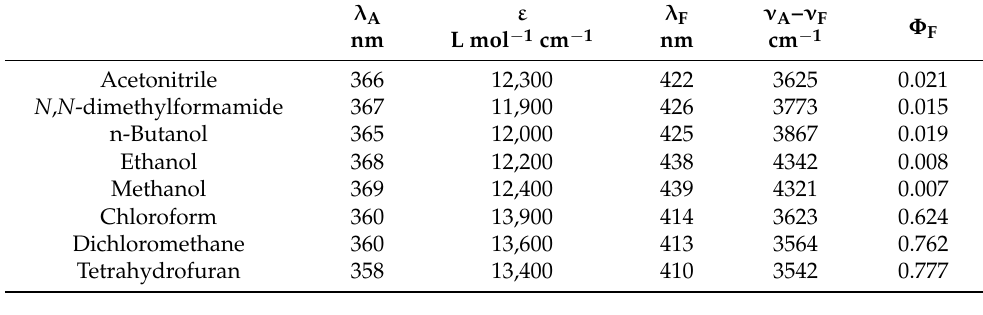
Table 2. Photophysical characteristics of compound NI2 in different organic solvents.